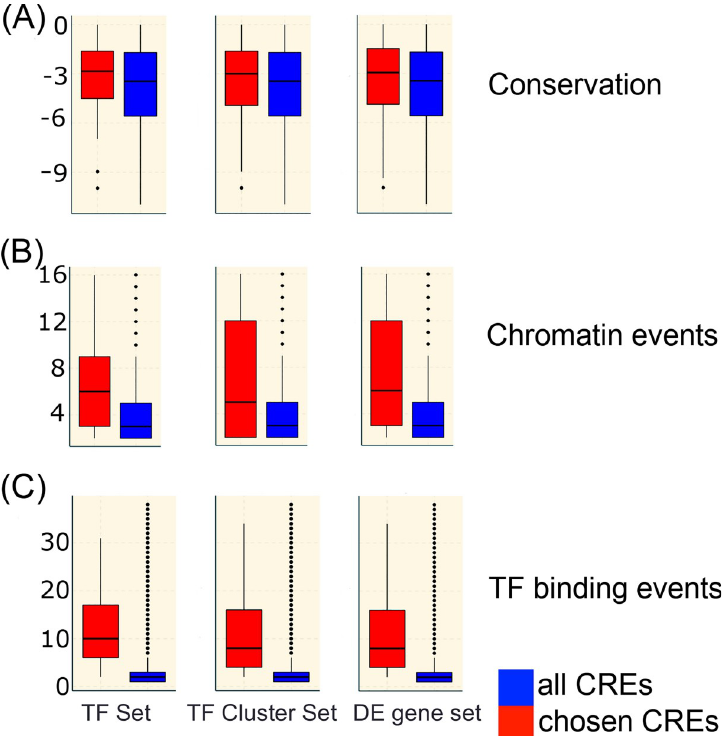
Fig 3. Characteristics of chosen regions. Conservation, chromatin events and TF binding events in chosen CREs (red) compared to all candidate CREs (blue). Left is the TF gene set, middle the TF cluster set and right all differentially expressed genes (DE set). (A) The log of the phylogenetic conservation scores (see Methods), (B) the chromatin events (H3K27Ac peaks and DHS), and (C) TF binding events. The p values were obtained using student t-test for conservation and Kolmogorov-Smirnoff test for chromatin and binding events. All the p values were less than 0.01 except for conservation distribution in TF set ( p = 0.07).